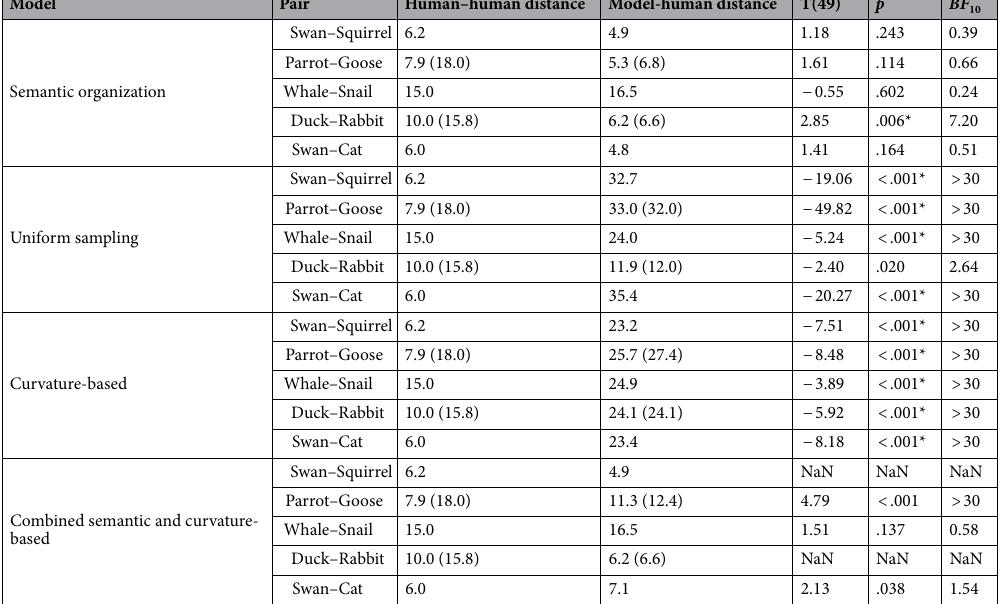
Table 2. Overview of modeling results and statistics for Experiment 2. Significant p values are marked with an asterisk (Bonferroni-corrected significance level p < .010). Note that the combined semantic and curvature- based model is tested against the semantic organization model rather than against human data (NaNs follow from exactly the same values for both models).